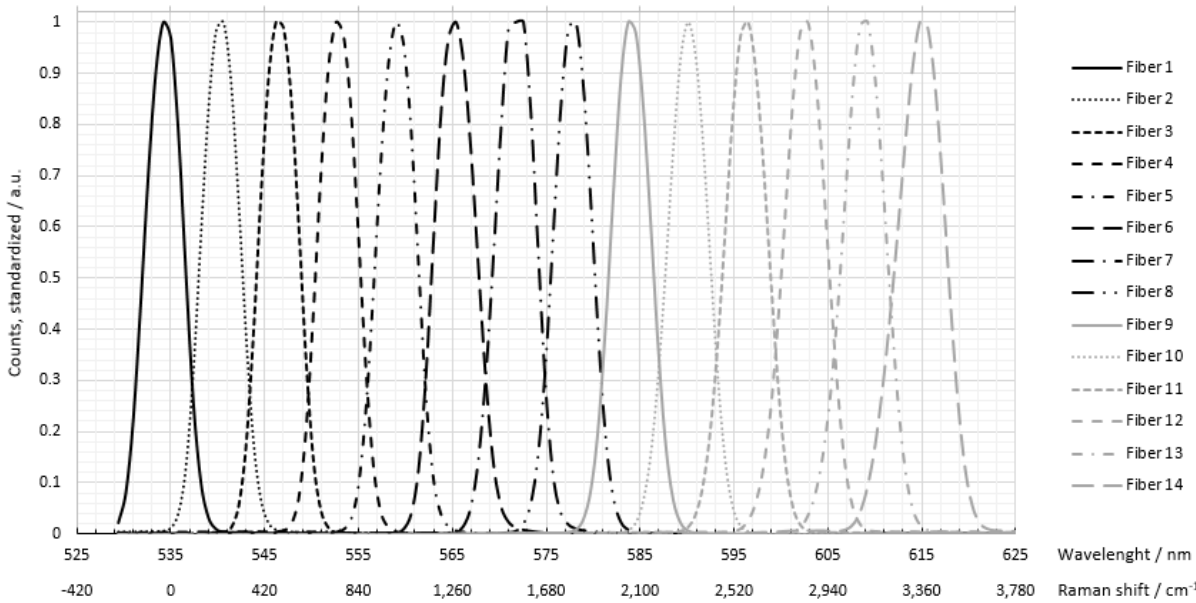
Figure 3. Resolution of the fiber array standardized and measured with a UV/VIS spectrometer (Zeiss, MCS621 VIS II). A halogen lamp (Zeiss, CLH600) was used as the light source.